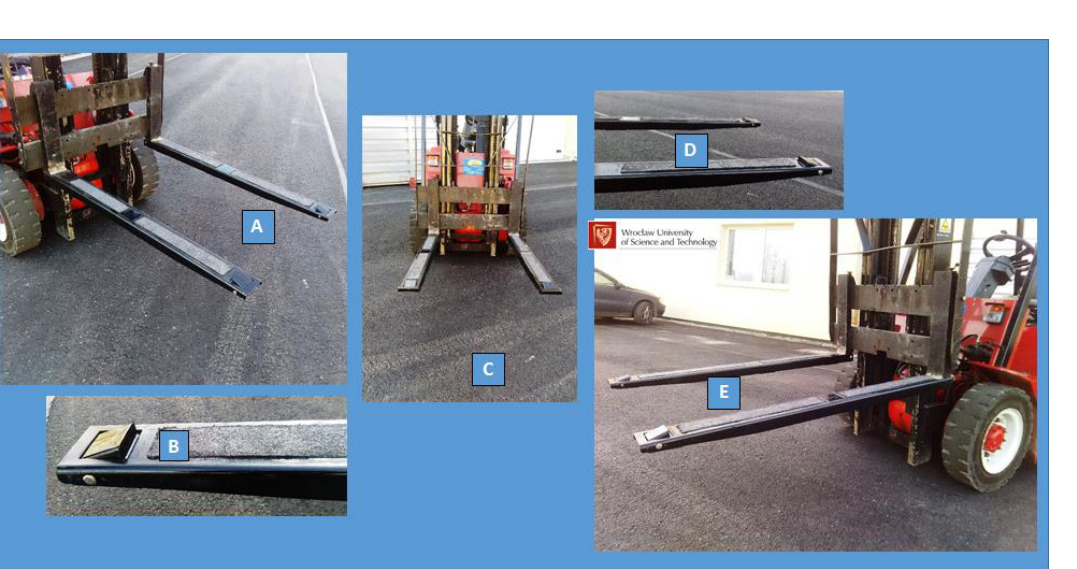
Figure 14. Prototype of pad mounted on a forklift. View of the forklift: ( A )—On the right side; ( B )—Pawl on the right side; ( C )—From the front; ( D )—On the left side; ( E )—Pawl on the left